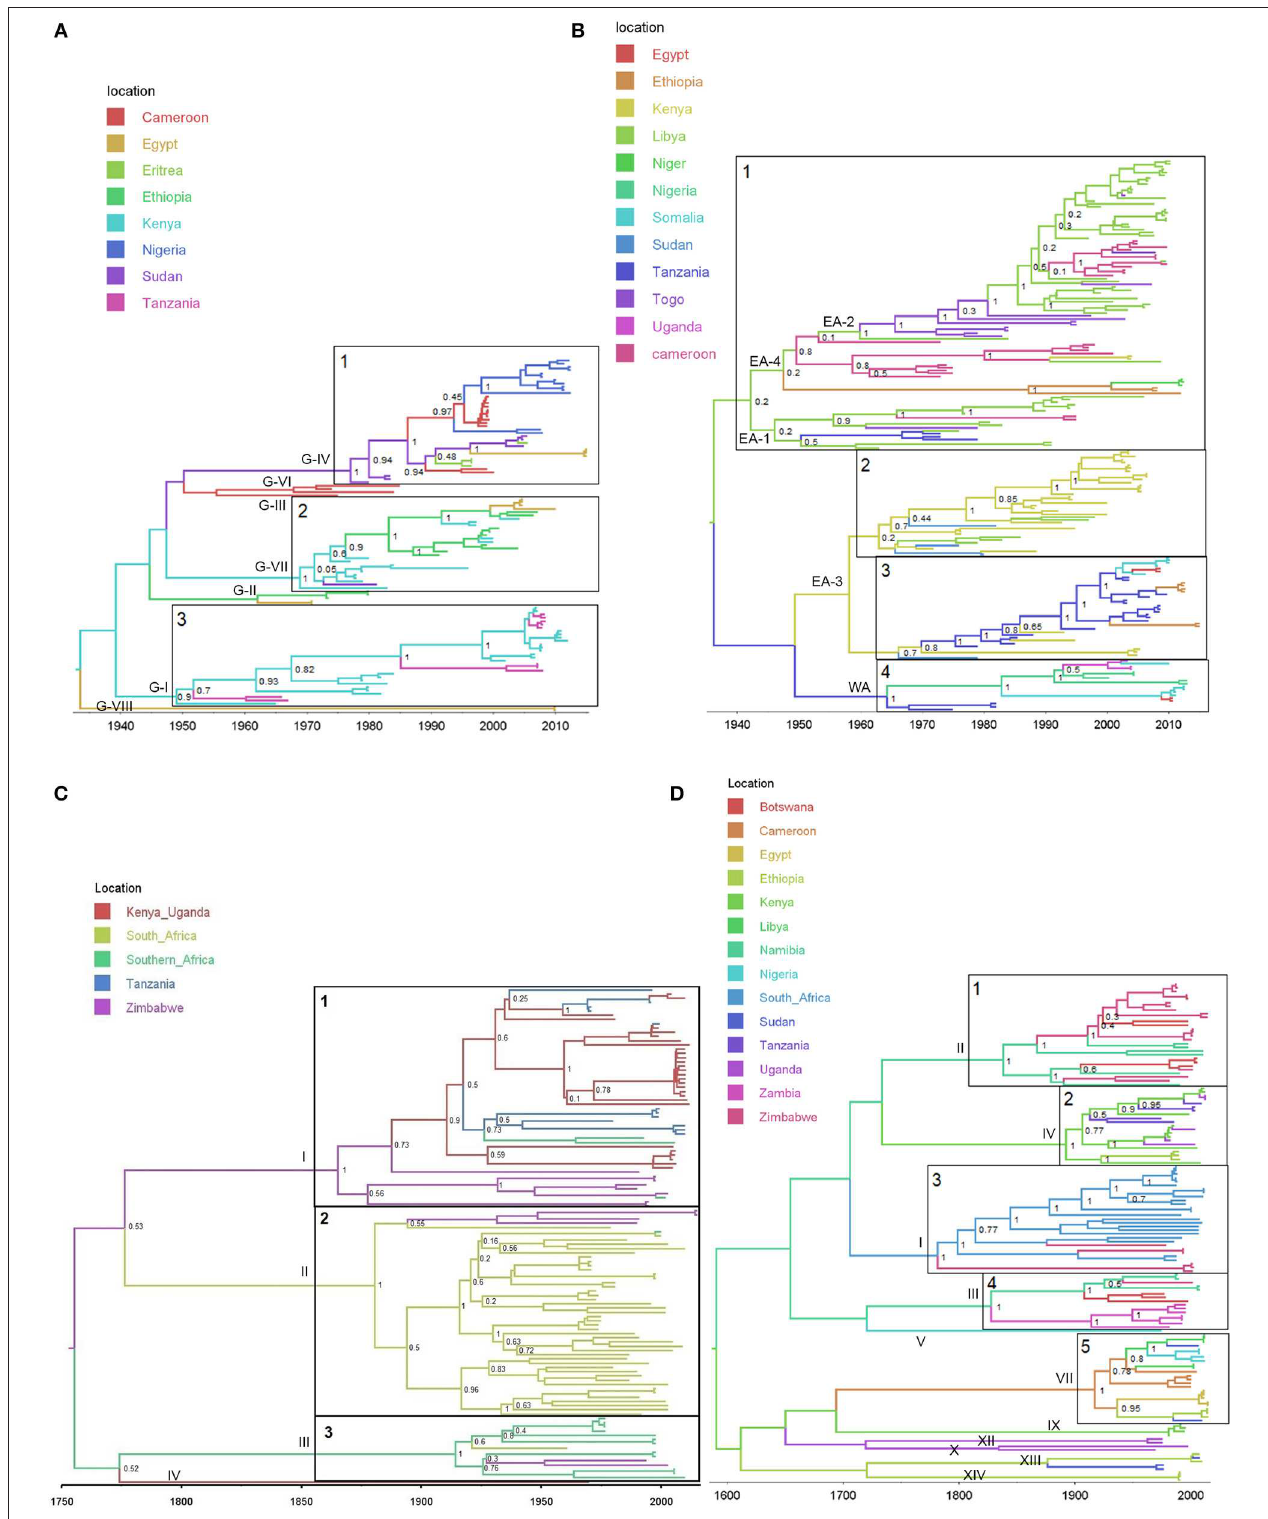
FIGURE 1 | Bayesian MCC time scaled discrete phylogeographic tree for the four studied serotypes. (A) Bayesian phylogeographic tree for serotype A using 107 VP1 sequences. (B) Bayesian phylogeographic tree for serotype O using 192 VP1 sequences. (C) Bayesian phylogeographic tree for serotype SAT1 using 117 VP1 sequences. (D) Bayesian phylogeographic tree for serotype SAT2 using 135 VP1 sequences. The phylogeny branches are colored according to their descendent nodes location with the key for colors shown on the right. The main clades for each of the studied serotypes are identified on the phylogeographic trees. The nodes of the isolated clades are annotated with their posterior